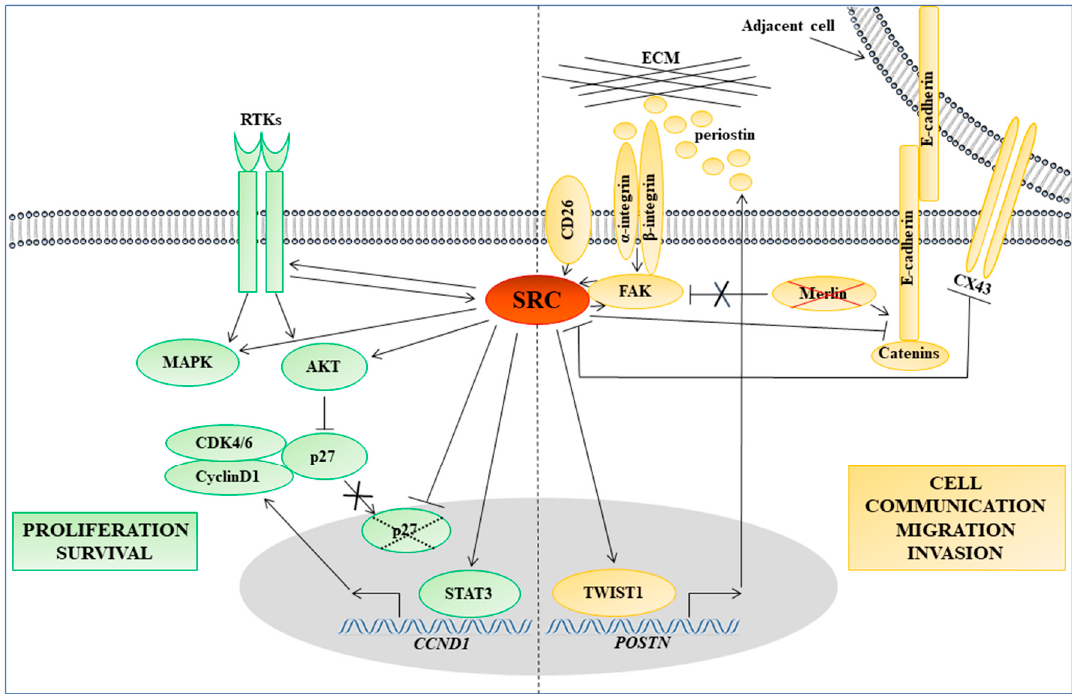
Figure 2. SRC-mediated molecular pathways formally assessed in malignant mesothelioma (MM). Receptor tyrosine kinases (RTKs) are frequently overexpressed and hyperactivated in MM and cooperatively interact with SRC to signal to downstream e ff ectors, such as the mitogen-activated protein kinase (MAPK) and AKT pathways, which promote cell proliferation and survival. Moreover, SRC and AKT cooperate to inactivate the nuclear tumor suppressor activity of p27: SRC accelerates p27 proteasome-mediated proteolysis (dotted X across p27), whereas AKT inhibits p27 through various mechanisms (mentioned in the main text), including the delay in its nuclear import (black X across the arrow). SRC also induces the expression of the CCND1 gene encoding cyclin D1, via activation of the signal transducer and activator of transcription 3 (STAT3). Cyclin D1-cyclin dependent kinase (CDK) 4 / 6 complex, which is a crucial component of the cell cycle machinery, can sequester p27, thus further contributing to the inhibition of its tumor-suppressive action. Di ff erent studies also implicated SRC in molecular pathways controlling MM cell communication, migration, and invasion. In particular, a crucial interacting partner of SRC is the focal adhesion kinase (FAK), a signaling component of focal adhesions, which are dynamic structures forming at the sites where integrins link the cytoskeleton to extracellular matrix (ECM) proteins. The mutually activated FAK-SRC complex promotes cell movement and invasion by a ff ecting multiple downstream pathways. Merlin, which is a tumor suppressor protein frequently lost in MM (red X across merlin) and involved in the maturation of adherens junctions (cell-cell adhesion structures composed of cadherin and catenin proteins), negatively regulates the FAK-SRC signaling. Thus, merlin loss could be an important step in the development of the invasive properties of MM cells since it leads to the de-repression of the FAK-SRC pathway (black X across the inhibitory connector). SRC is also involved in mediating MM cell migration and invasion induced by high cell surface levels of the transmembrane glycoprotein CD26. In particular, CD26 induces the nuclear translocation of the transcription factor TWIST1 via SRC activation; this results in enhanced expression and secretion of periostin, a matricellular protein involved in the promotion of cell migration and invasion. SRC is also implicated in controlling the gap junction (GJ) intercellular communication, which occurs through the pore-forming proteins connexins (CXs) and is markedly reduced in MM cells. In particular, CX43, the most widely expressed GJ protein, is a direct substrate of SRC.